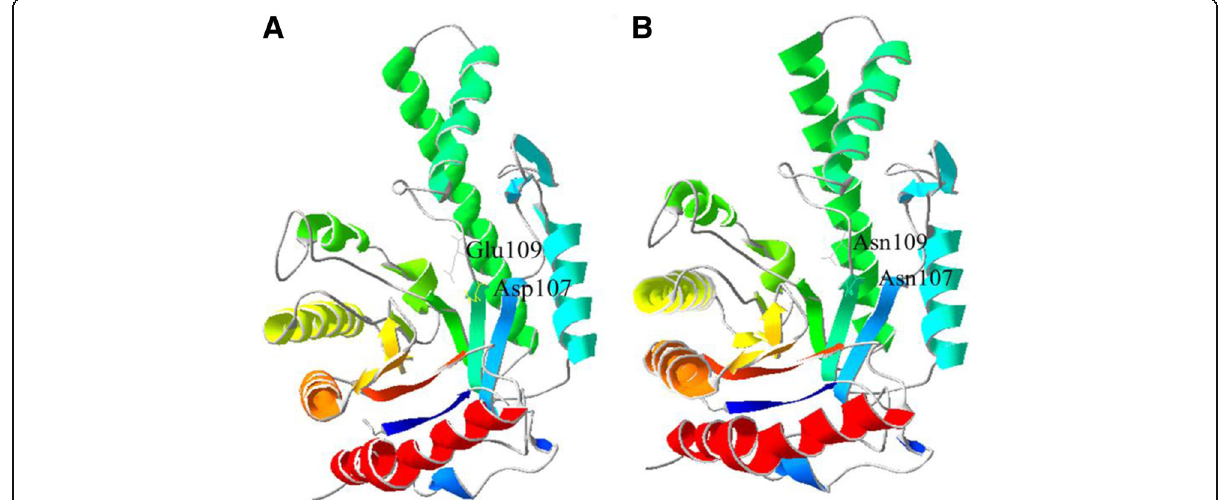
Fig. 7 The predicted three-dimensional structural modelling of VesT2s. The Vespa tropica HAase [VesT2a ( a ) and VesT2b ( b )] modelling used VesV2